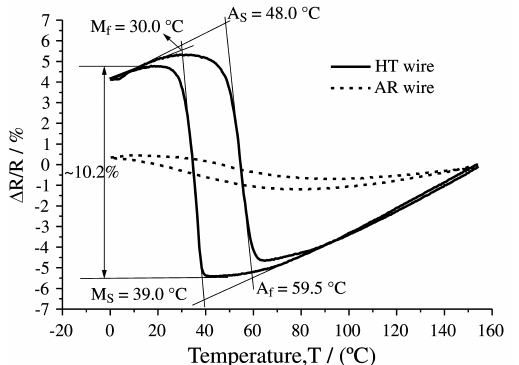
Figure 1. ∆ R/R vs. T of the as-received (AR) and heat-treated (HT) Ti-Ni-Cu wires.